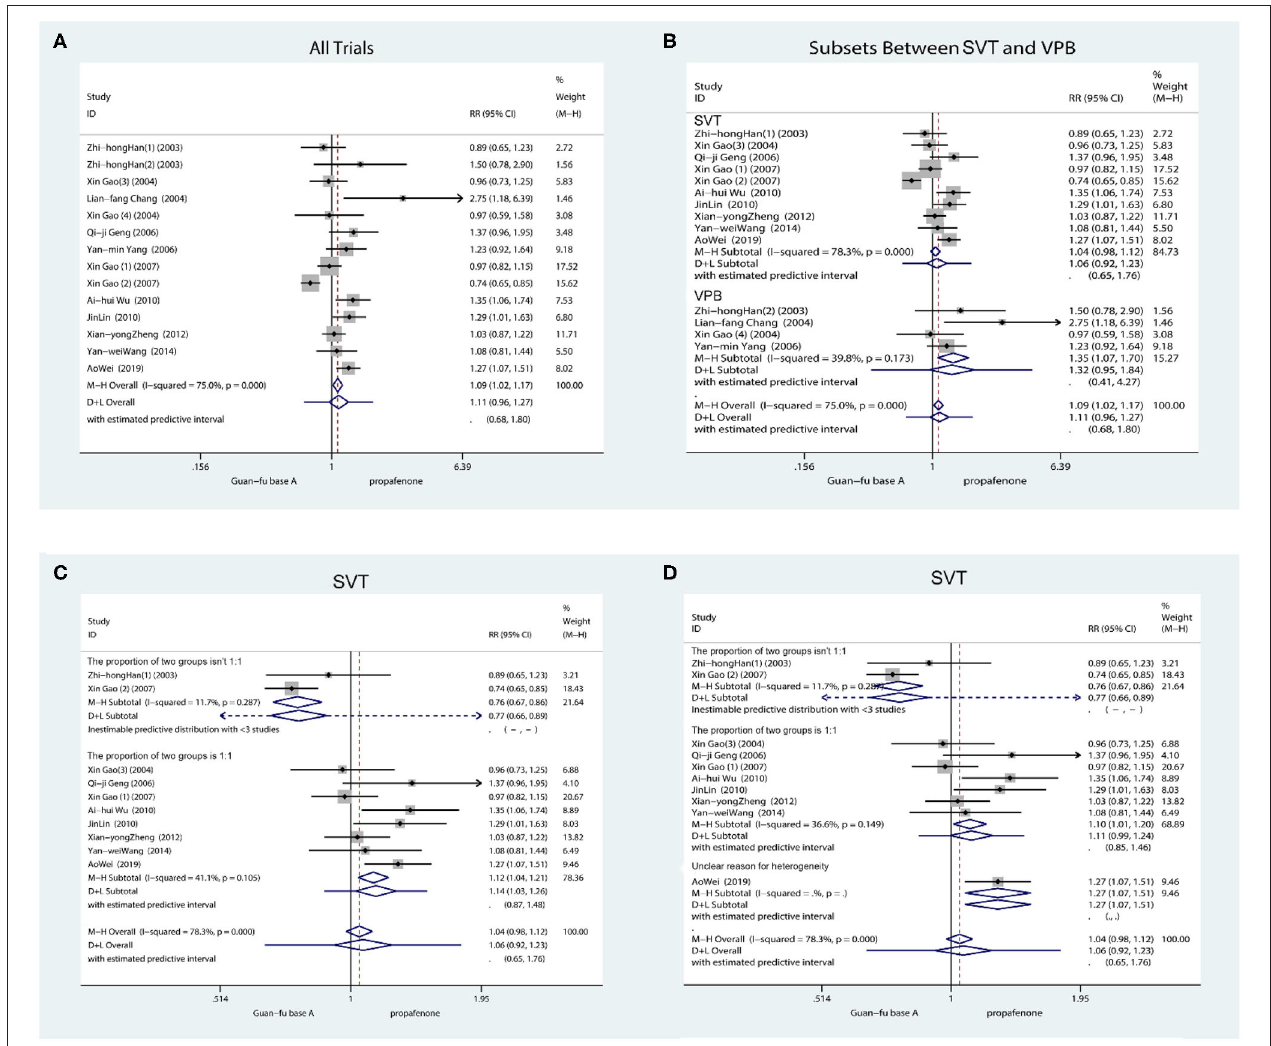
FIGURE 2 | Forest plot comparing the GFA with propafenone in efficiency. (A) Forest plot comparing the GFA with Propafenone for all study. (B) Forest plot comparing the GFA with Propafenone in subgroups (SVT and VPB). (C) Forest plot comparing the GFA with Propafenone for SVT without articles of “Zhihong Han (1)” and “Gao Xin (2).” (D) Forest plot comparing the GFA with Propafenone for SVT without articles of Xin Gao